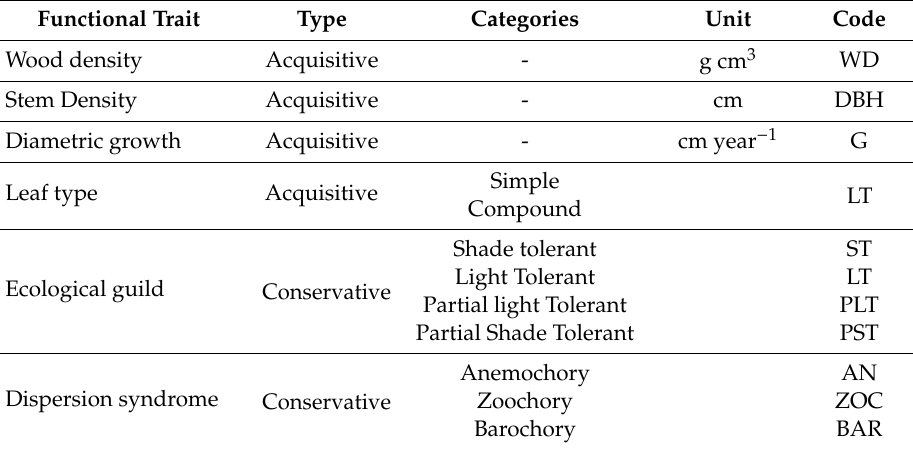
Table 1. Functional (conservatives and acquisitive) traits, including categories, units and codes used to calculate FD and